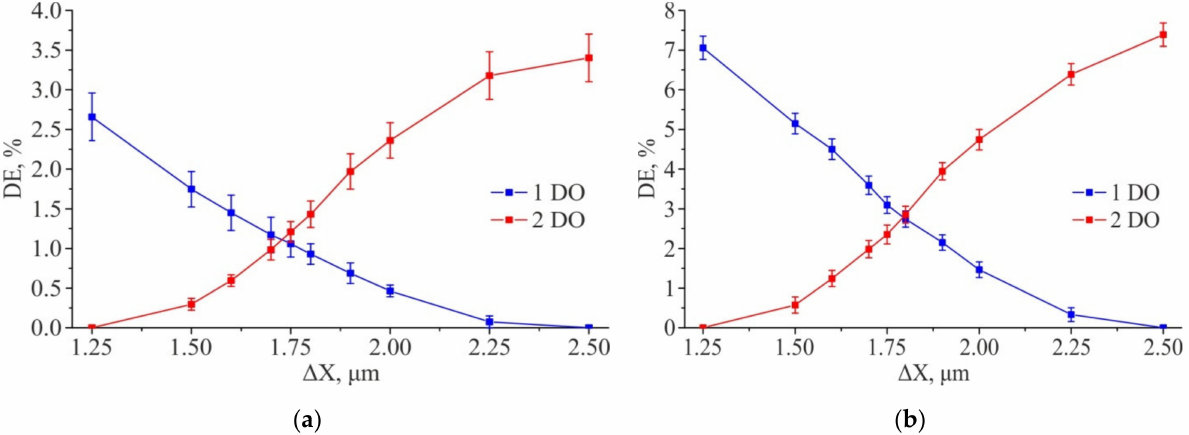
Figure 14. Measurement of diffraction efficiency of experimental 1D DSE structures written: on CLWS300IAE ( a ); on DWL66+ ( b ).